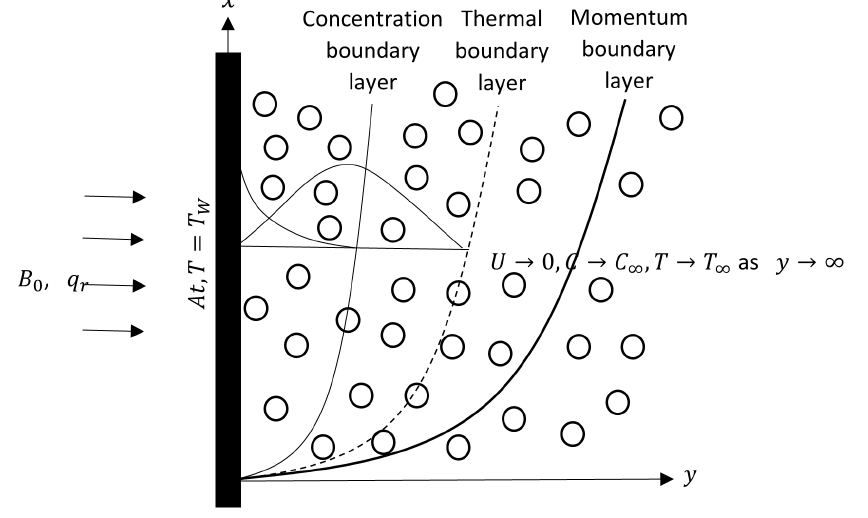
Figure 1. Physical